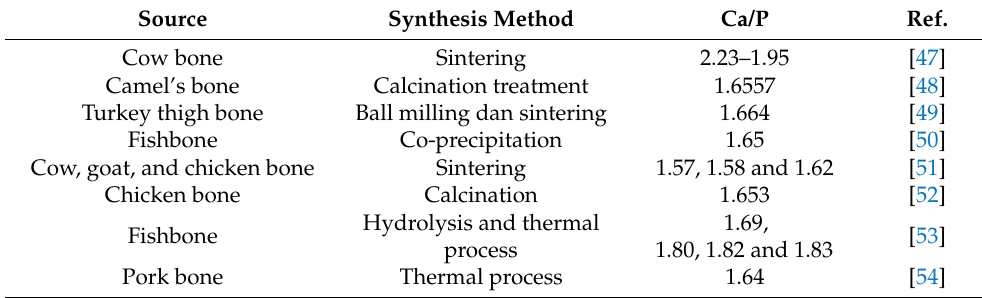
Table 1. Results of various studies for the synthesis of Bio-waste HA.